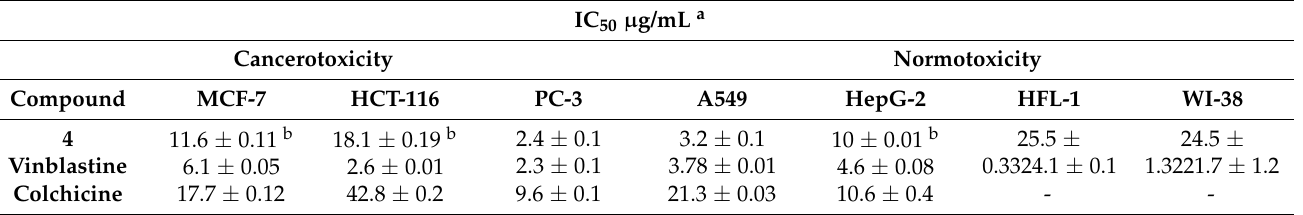
Table 1. IC 50 values ( µ g/mL) of the target compound 4 against MCF-7, HCT-116, PC-3, A549, and HepG-2 cell